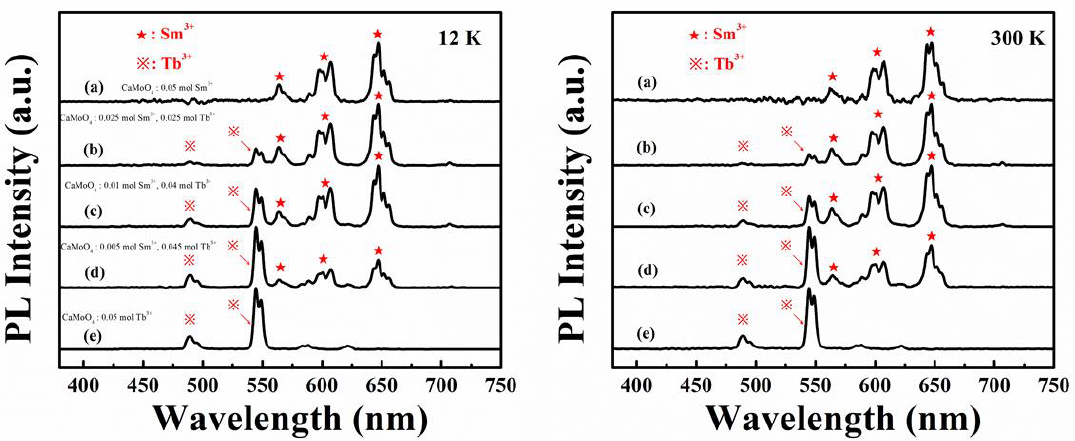
Figure 4. Spectra of 12 and 300 K PL with a molar ratio of (a) 0.05:0, (b) 0.025:0.025, (c) 0.01:0.04, (d) 0.005:0.045, and (e) 0:0.05.